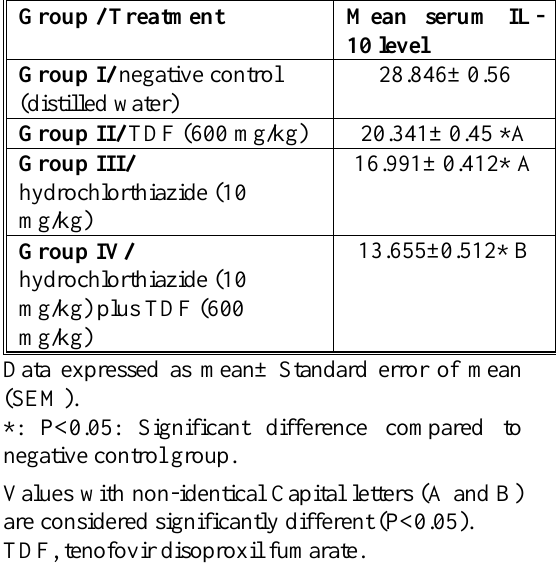
Table 2. Effect of different treatments on interleukin-10 level in serum of rats' groups. Group / Treatment